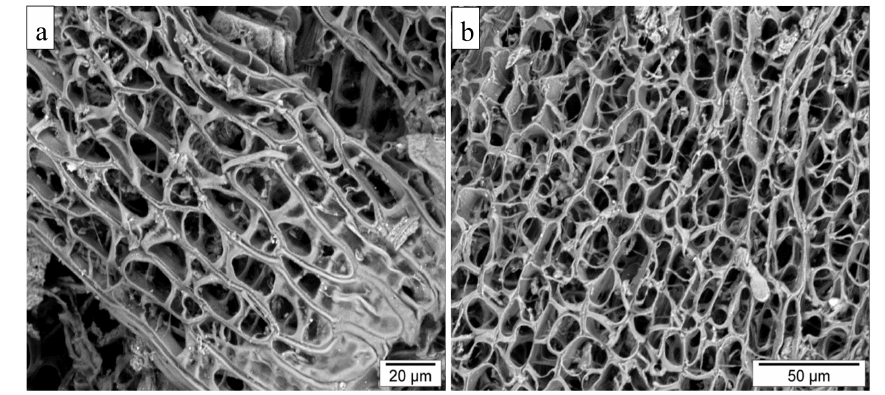
Figure 1. Scanning electron microscope pictures of samples of the peat used in this study. (a) Moss with hyaline cells; note cells with intact membrane at bottom right corner and larger pore spaces in bottom left and top right corners. (b) Hyaline cells with membranes missing; the view through the skeleton is evident. Modified from Rezanezhad et al.